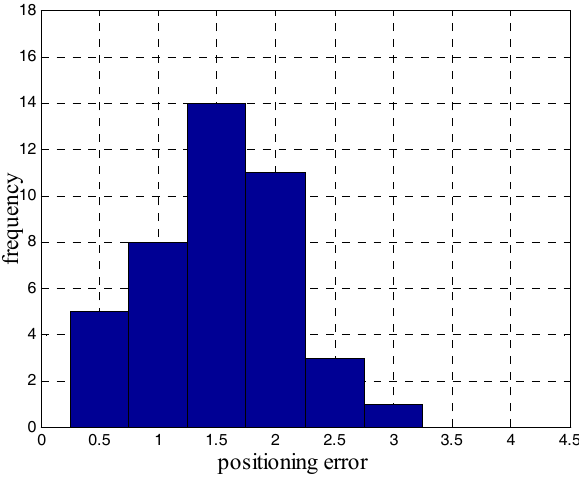
Figure 16. The positioning errors of the proposed method.